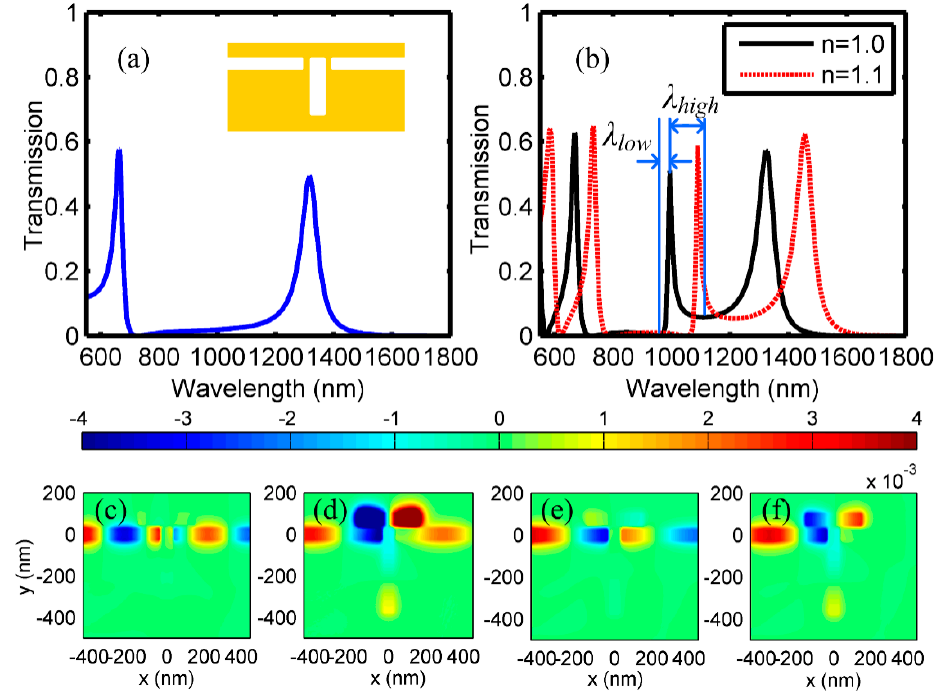
Figure 2. ( a ) Transmission spectrum of the proposed structure with only cavity A, ( b ) Fano spectra of the proposed structure with both cavities (black solid line for n = 1.0, red dash line for n = 1.1), and ( c – f ) The magnetic field distributions at the peak- or dip-wavelengths at 667 nm, 993 nm, 1322 nm, and 958 nm, respectively (corresponding to the spectra in ( b ) with n = 1.0).